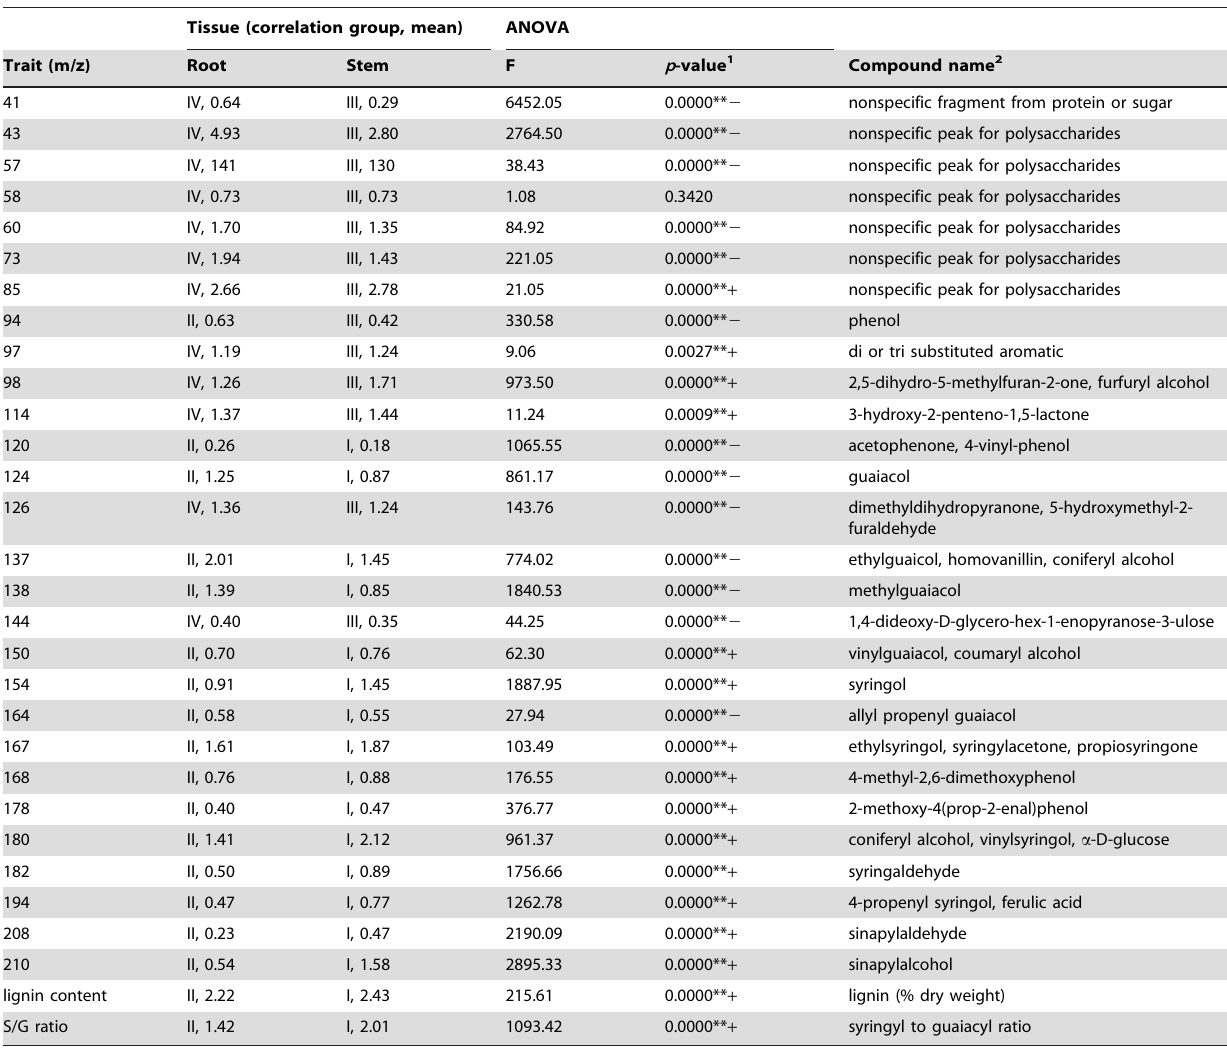
Tissue (correlation group,